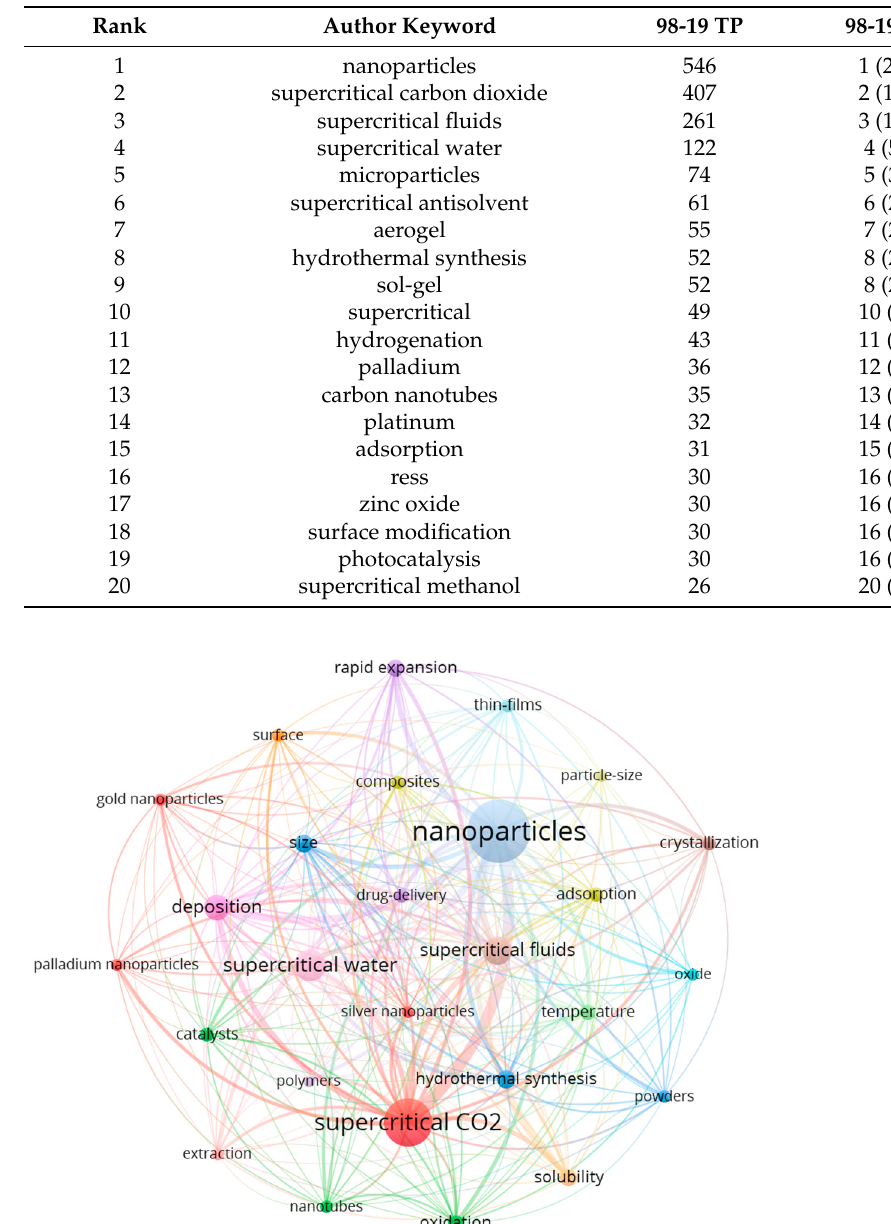
Table 4. Top 20 keywords with the highest frequency from 1998 to 2020.